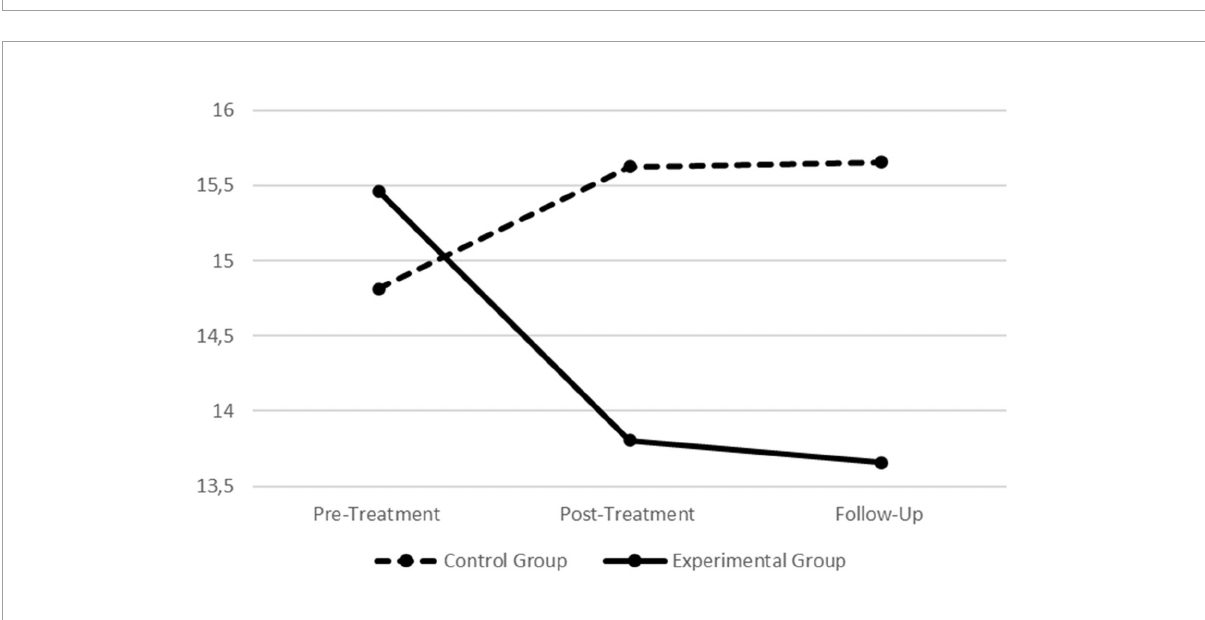
FIGURE6 Graphic presentation of group differences in the Difficulties in Emotion Regulation Scale–Adolescent Version (DERS-AV) goals subscale across the pre- treatment, post-treatment, and follow-up assessment periods.